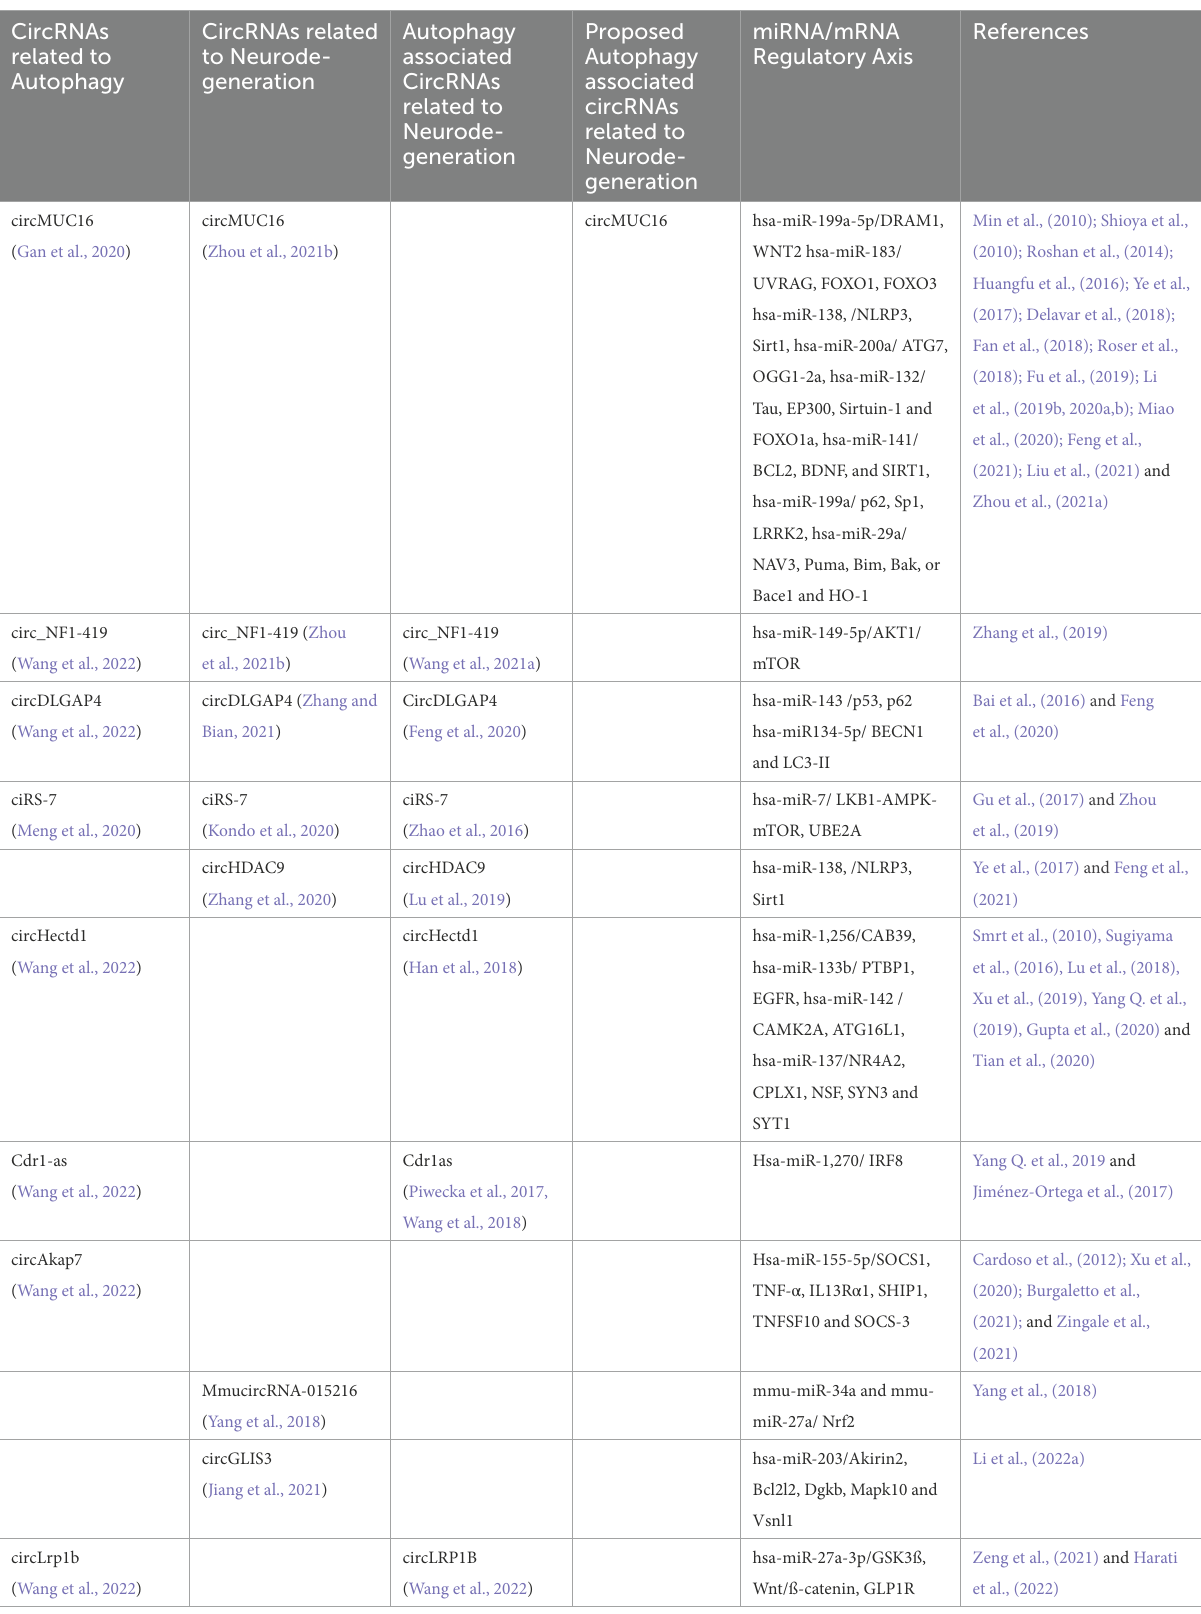
TABLE 2 List of autophagy associated circRNAs and neurodegeneration associated circRNAs along with possible connection and